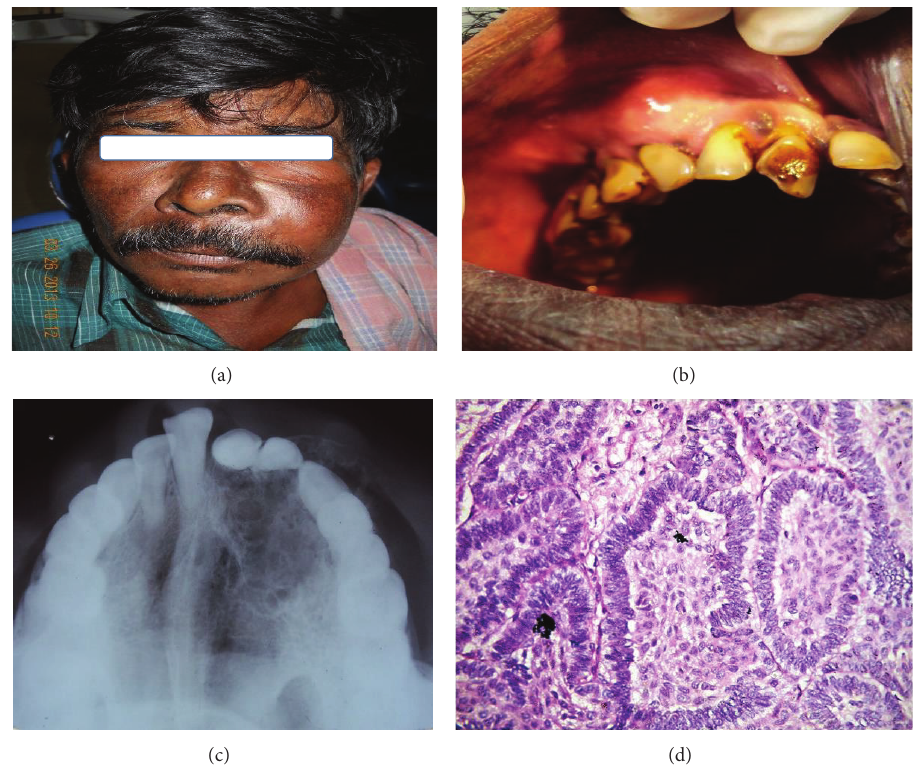
Figure 4: (a-b) Preoperative view. (c) Occlusal radiograph. (d) Follicular type